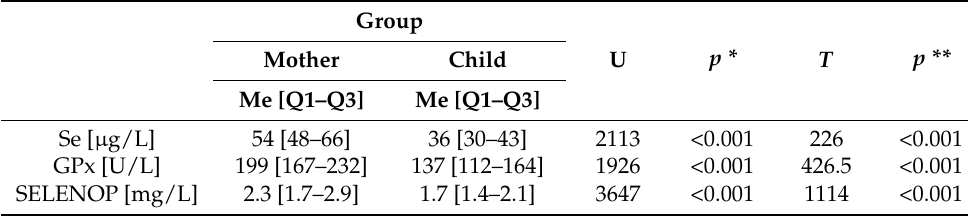
Table 2. Selenium status in the mothers and the newborns.